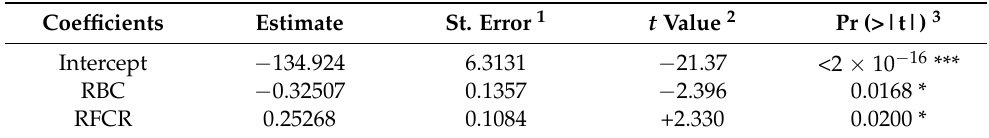
Table 1. Stepwise Regression results showing the subset of variables that impact the needle passing task.